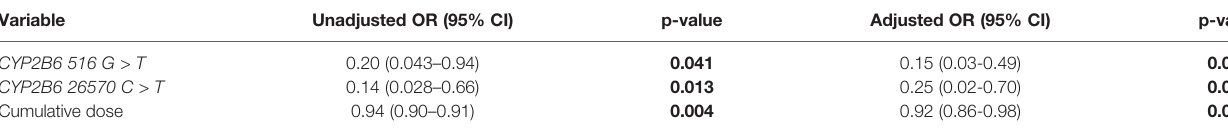
TABLE 3 | Multivariate logistic regression for potential association with mitotane underexposure (C < 14 mg/L).